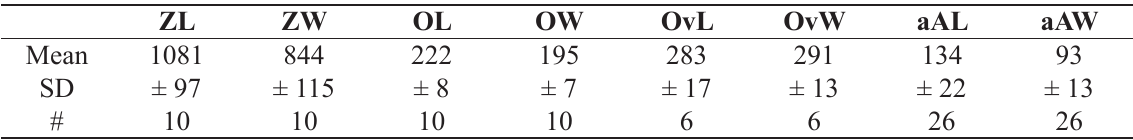
Table 14. Measurements of Calvetopora otapostasis gen. et sp.